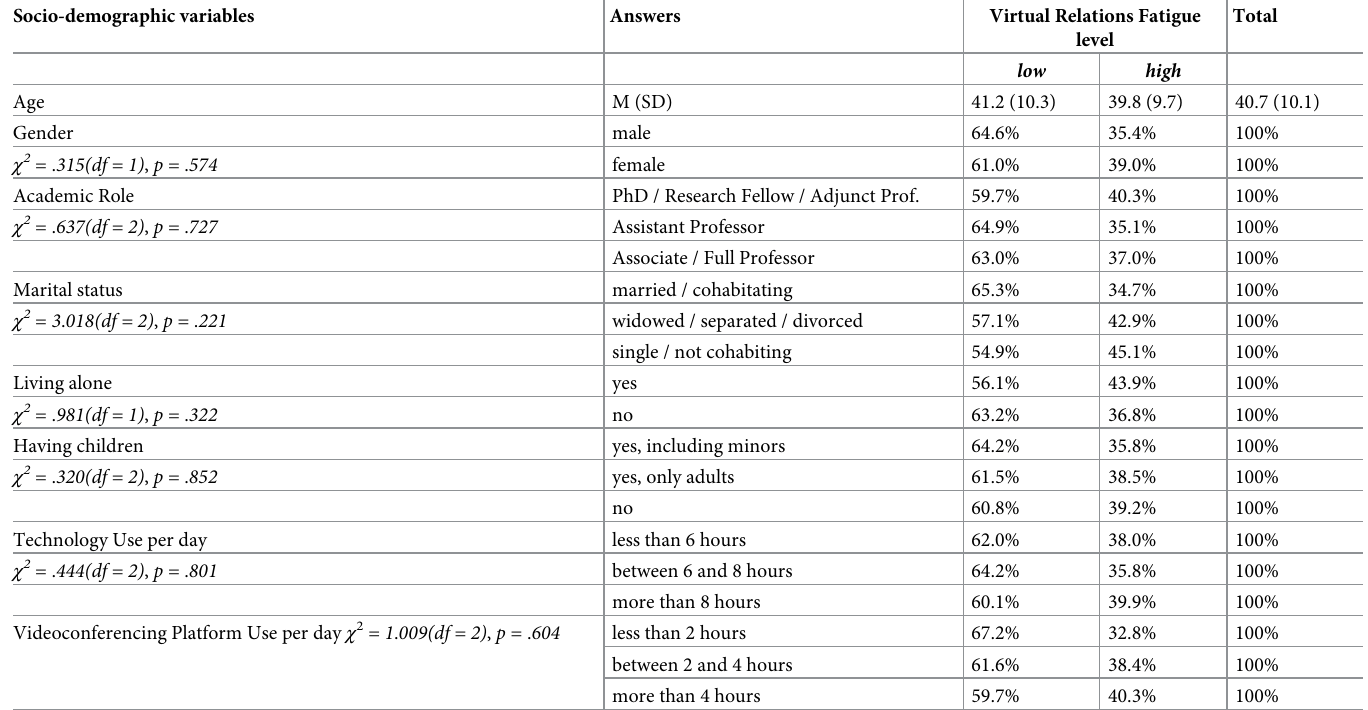
Table 7. Results of contingency table–Virtual relations fatigue